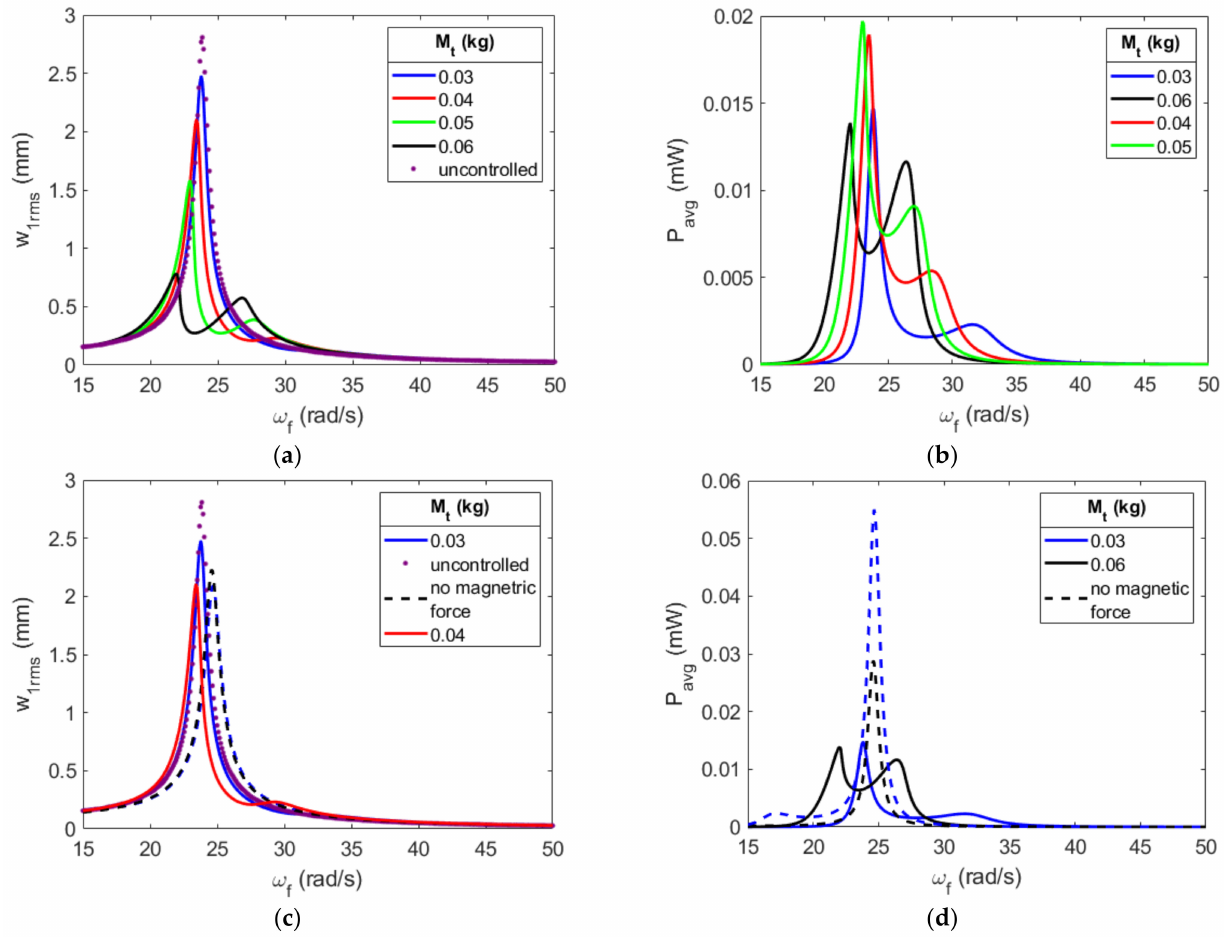
Figure 19. The effects of varying tip masses with a substrate thickness of 0.3 mm and an initial gap of 7.5 mm on the amplitude of the ( a ) primary structure and ( b ) absorber, as well as a comparison with configurations with no magnets ( c , d